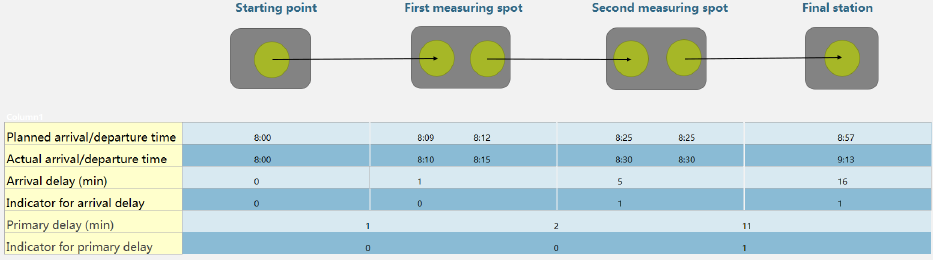
Figure 1. Illustration of a train run with derived indicators for primary and arrival delays.